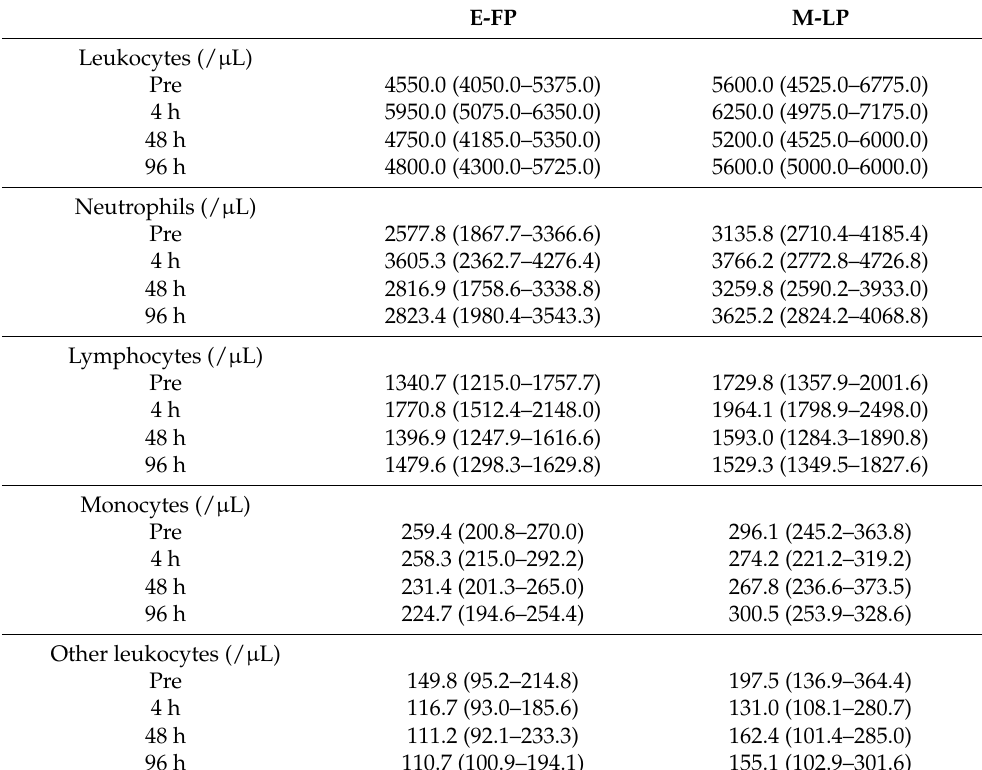
Table 2. Leukocyte counts at pre- and 4, 48, and 96 h